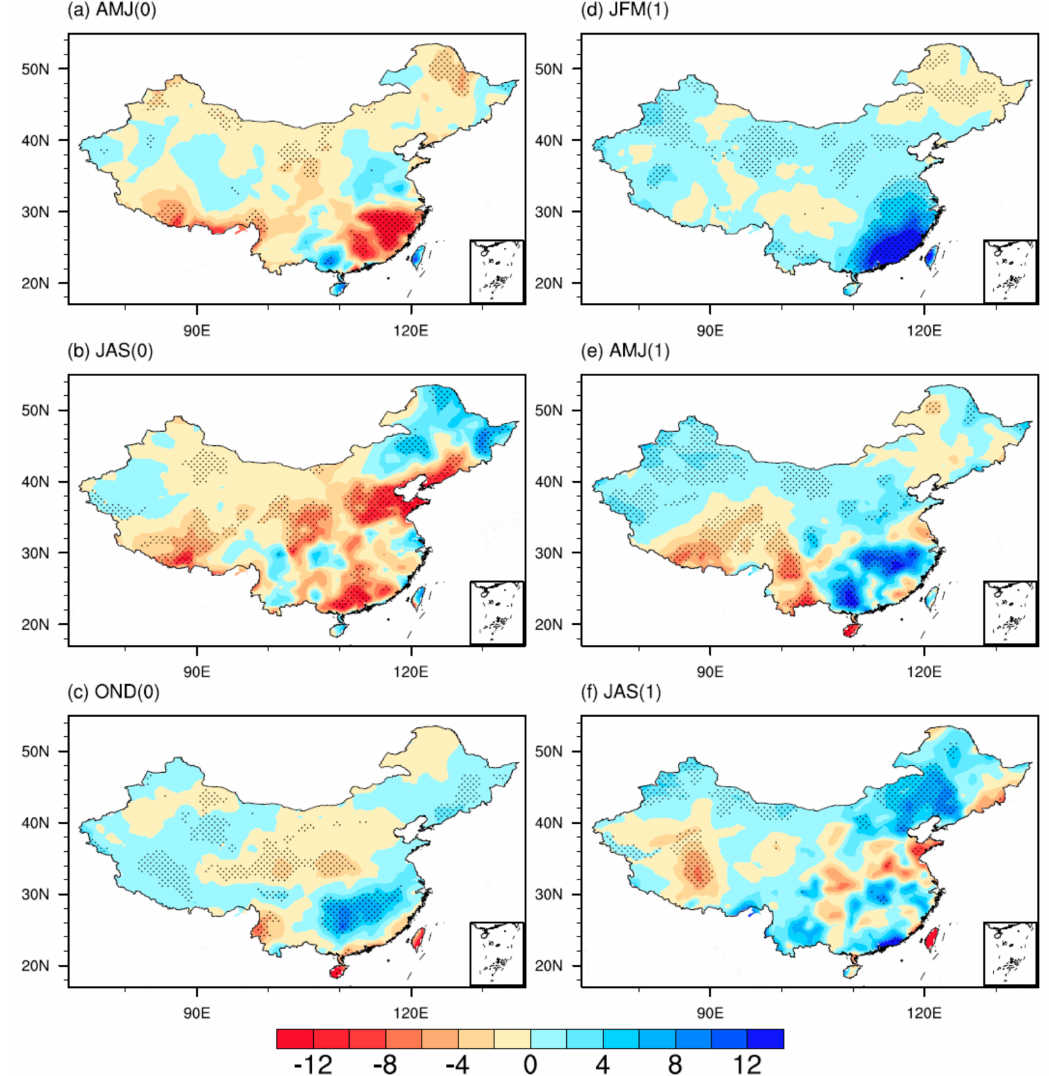
Figure 4. Partial regression coe ffi cients (mm / day per ◦ C) of the precipitation anomalies onto the Nino3.4 index, having removed the influence of IOD during the period of 1950–2013. Shown are during ( a ) April to June (AMJ(0)), ( b ) July to September (JAS(0)), and ( c ) October to December (OND(0)) in the developing phase, and the following ( d ) January to March (JFM(1)), ( e ) April to June (AMJ(1)), and ( f ) July to September (JAS(1)). The stippling indicates statistically significant at the 90%